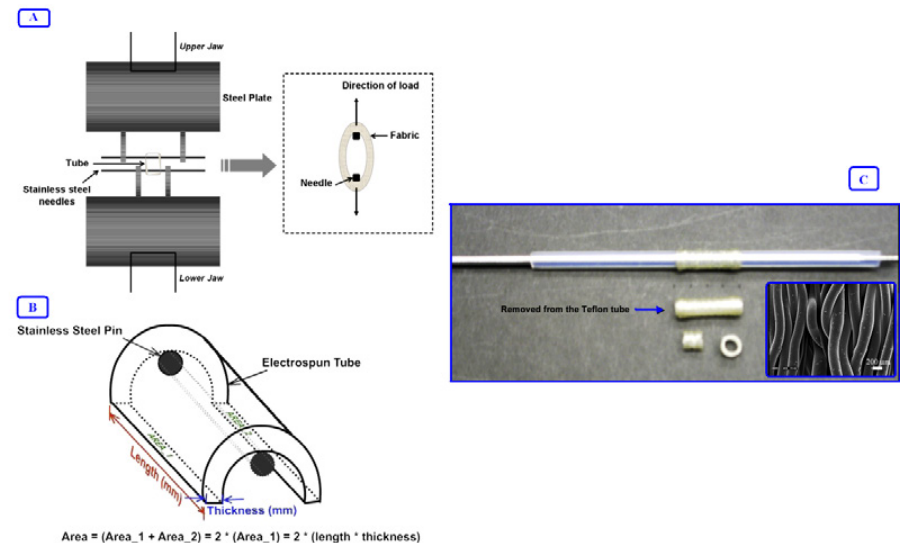
Figure 8 : (A) Commissioned holding border , (B) diagram presentation area ― calculation ,